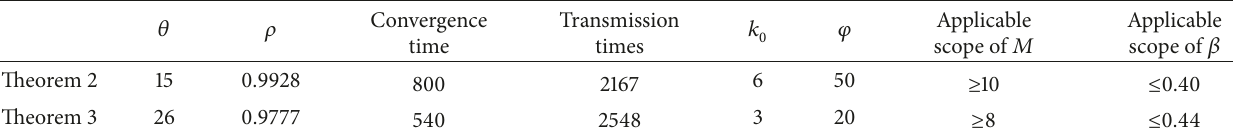
Table 1: Comparison of the parameters in Theorems 2 and 3.